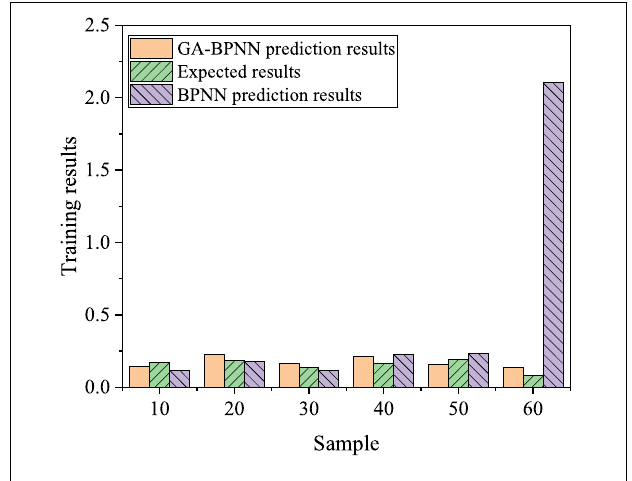
FIGURE 15 | Sums of squares of errors.